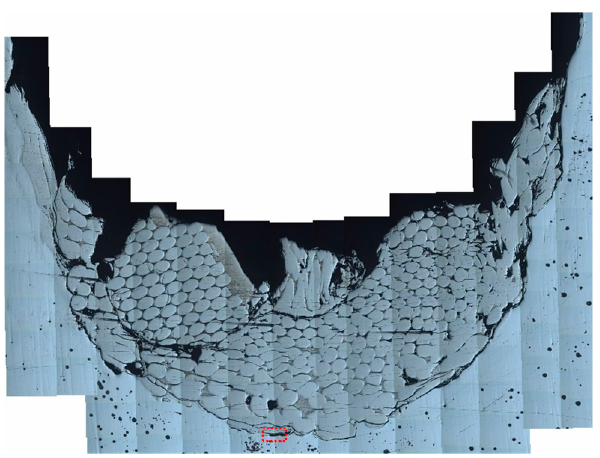
Figure 6. Metallographic photo of residual WF/Zr-MG rod (No. C2) at 1523 m/s.